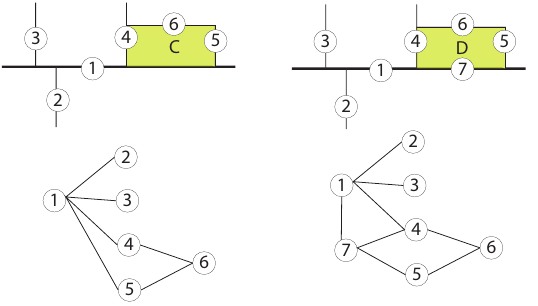
Figure 3. Comparison of green space position with different